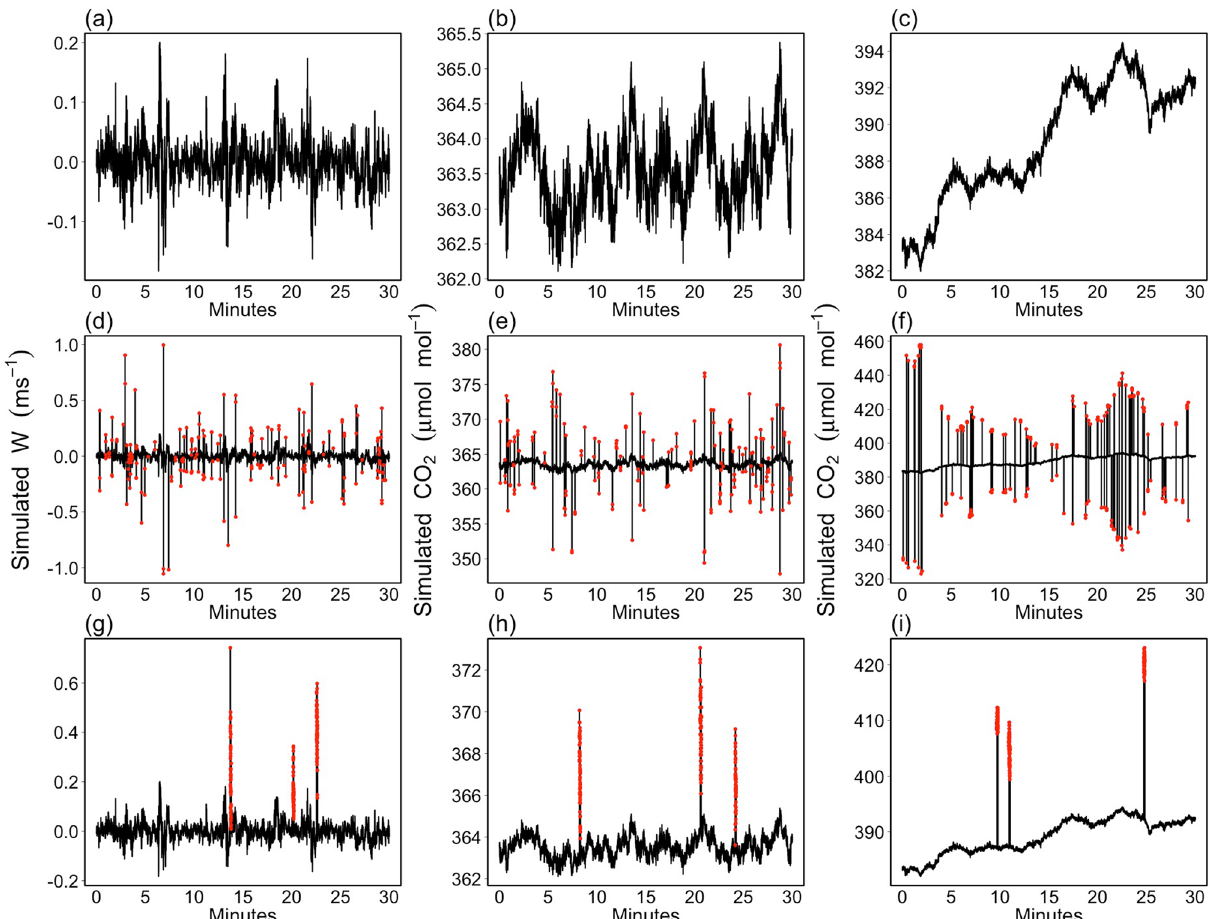
1 , a ) and stationary ( b ) 1 ). ( d – f ) and ( g – i ) The same time series